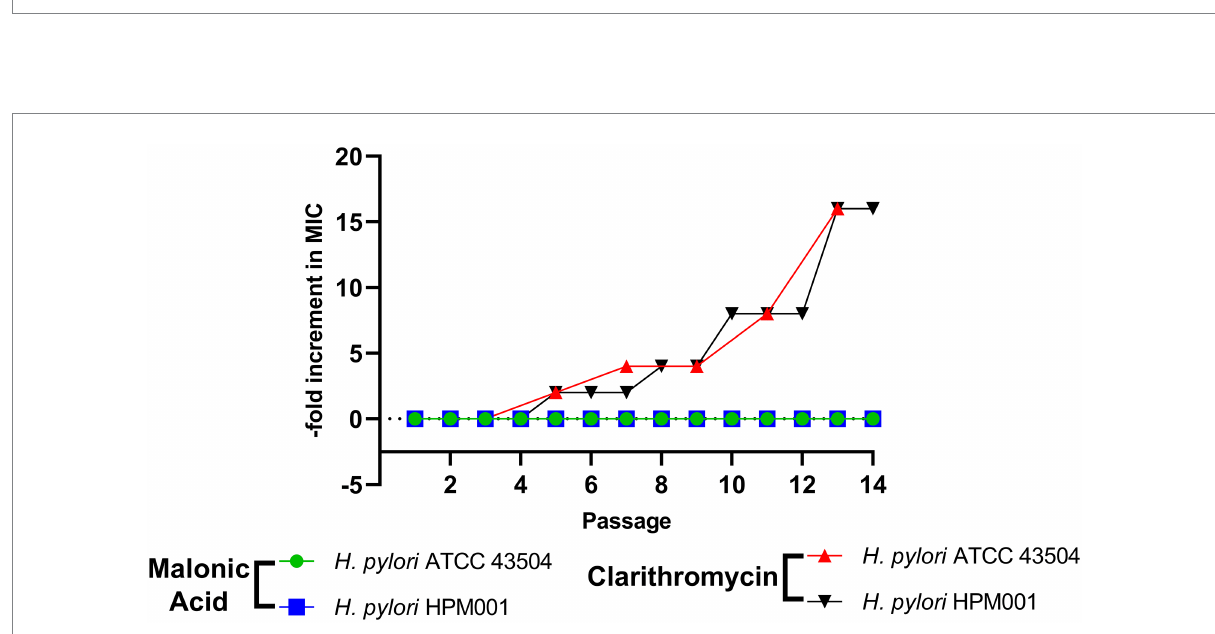
FIGURE 5 Lack of resistance development in Helicobacter pylori by repeated exposure to aspartate α -decarboxylase inhibition using malonic acid. Fold increase in minimum inhibitory concentration (MIC) of malonic acid and clarithromycin against H . pylori ATCC 43504 and the clinical H . pylori HPM001 isolate, following 14 serial